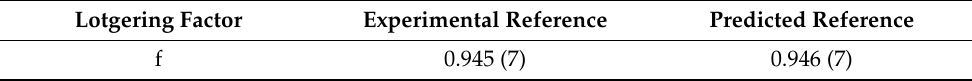
Table 1. Summary of Lotgering factor for textured BNT-BT-KNN determined using either an experi- mental reference (powder diffraction pattern) or theoretical reference (modeled diffraction pattern from the crystallographic model). In addition, estimated errors in the Lotgering factor are reported in the